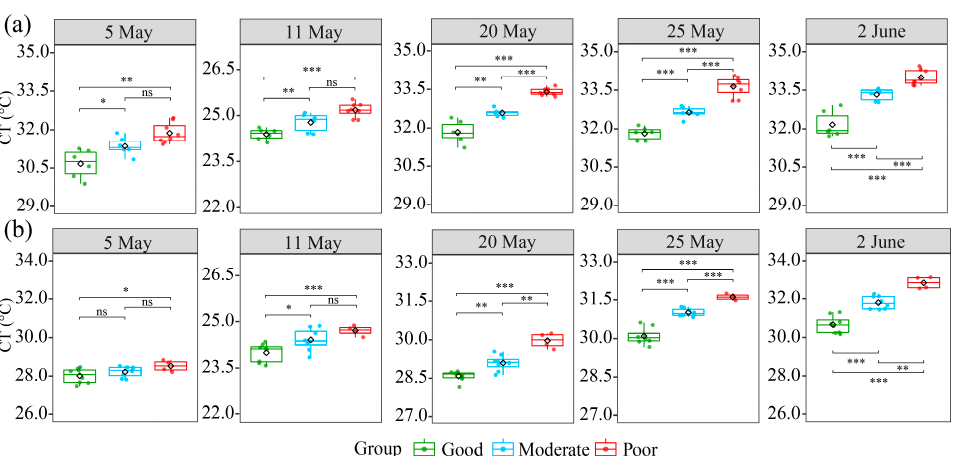
Figure 10. Comparison of canopy temperature of different drought-resistant performance groups measured at five growth stages. Among them, ( a ) W0, no irrigation during the growing season and ( b ) W1, irrigation at jointing. Black “ ” represents the average value of the group, and the black (cid:51) horizontal line represents the comparison between the two groups. In addition, the significance analysis is based on the t -test method, p > 0.05, is ns, 0.01 < p < 0.05, is *, 0.001 < p < 0.01, is **, p < 0.001, is